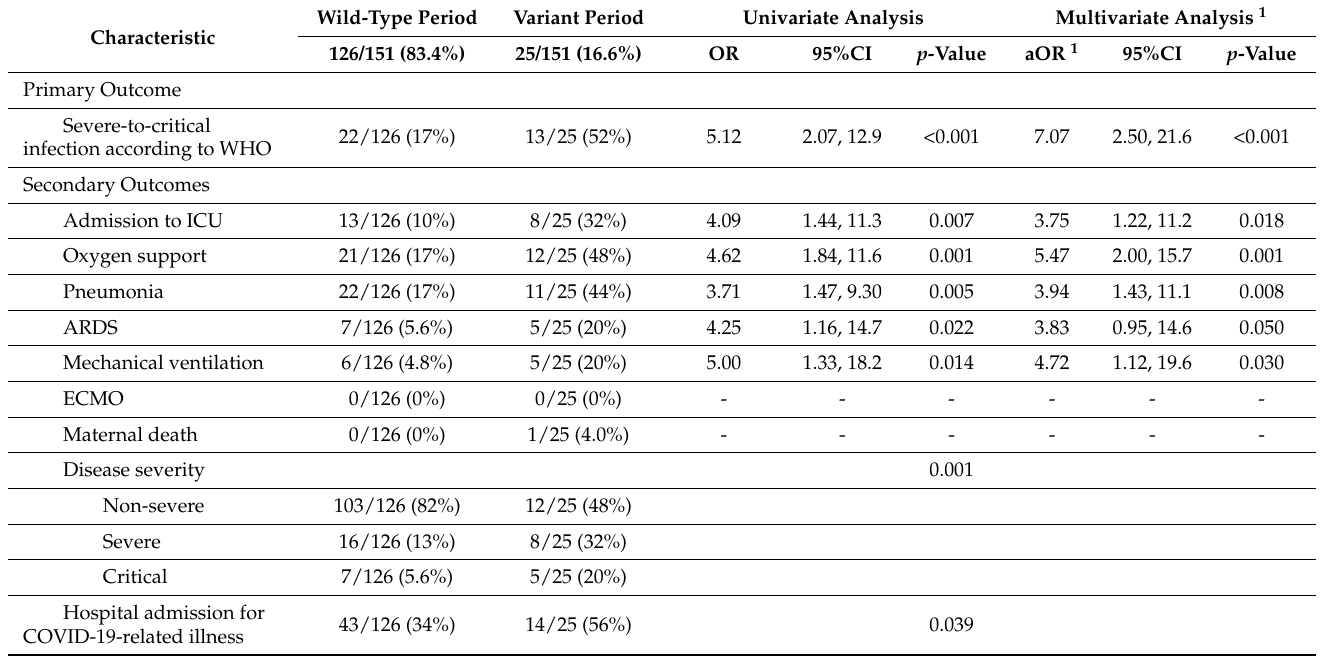
Table 2. Disease severity among symptomatic pregnant women during the “wild-type period” and “variant period”.